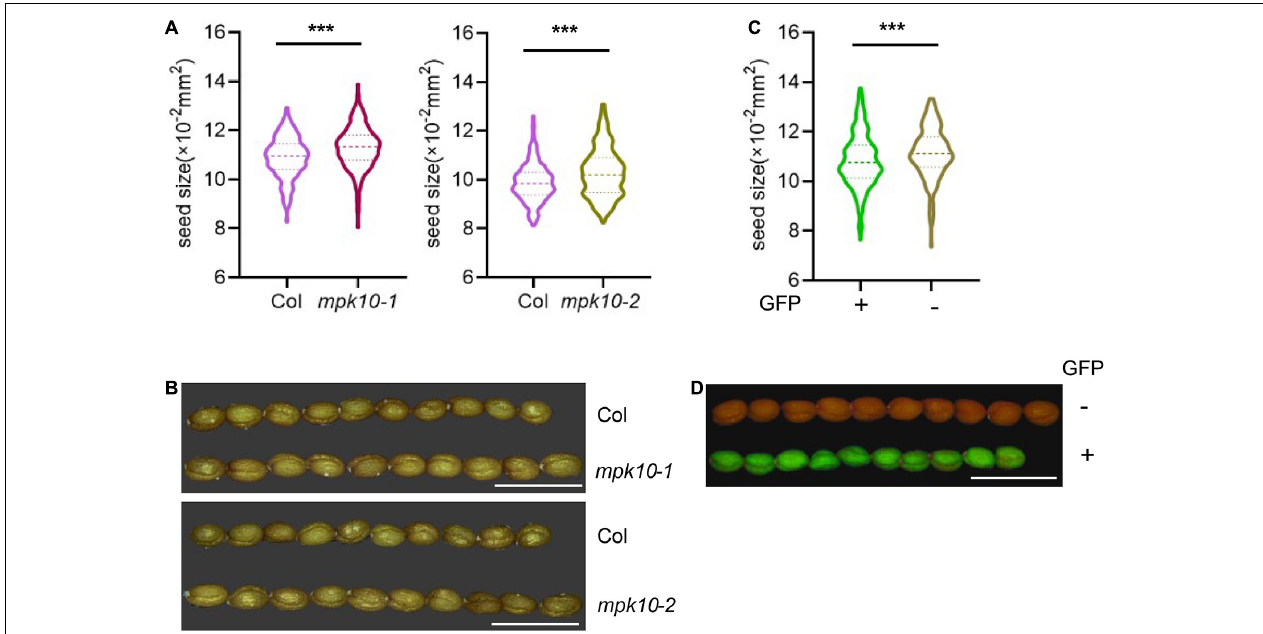
FIGURE 5 | mpk10 mutants lead to big seed phenotype. (A,B) The mpk10 mutants produce big seeds, and the seed areas increase around 4% comparing to wild type seeds. mpk10 -1 is a T-DNA insertion mutant, and mpk10-2 is a mutant created by CRISPR. (C, D) Big seeds of phenotype of mpk10-2 were rescued by a complementation construct with seed fluorescence selection marker driven by promoter of At2S3 encoding a seed storage protein. The GFP positive seeds (complemented) were smaller than the GFP negative seeds (control) from the same transgenic plant. The statistical significances are determined using student’s t -test. * P < 0.05, ** P < 0.01, *** P < 0.001. Values are mean ± SD. Bar = 1.25